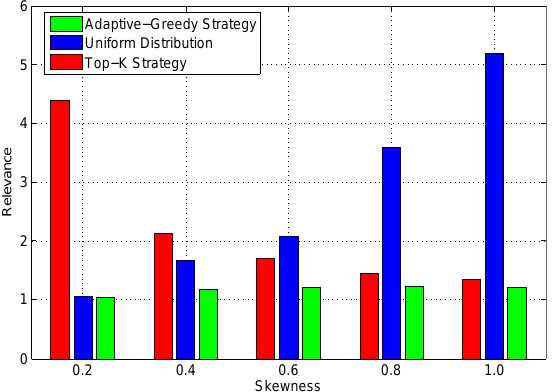
Figure 11. Performance comparison with different